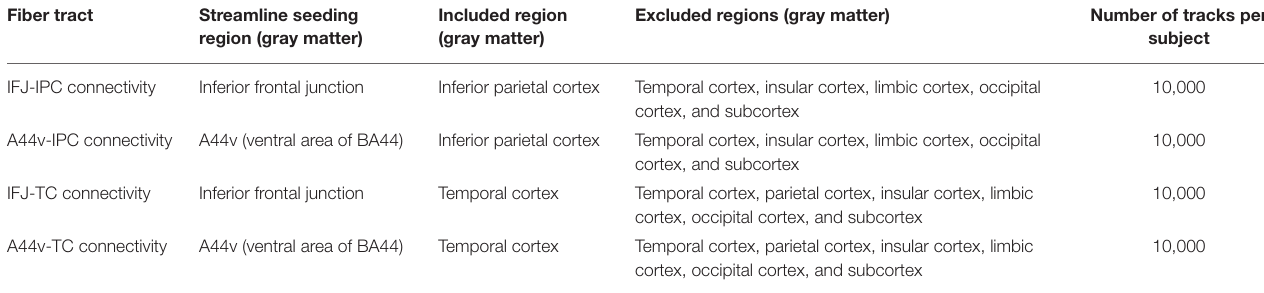
TABLE 3 | Guideline for reconstructing fiber tracts originated from the major PFC subregions.